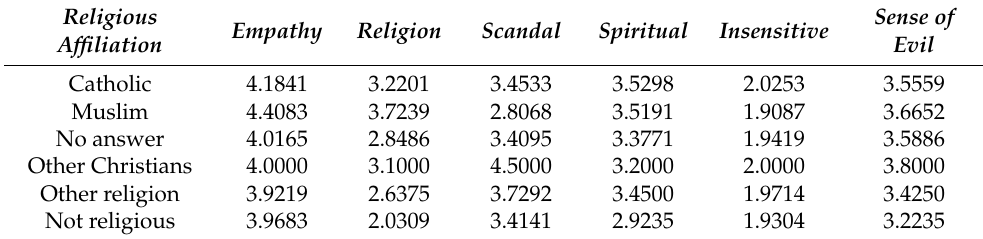
Table 3. Comparing means among different religious affiliations and extracted factors.